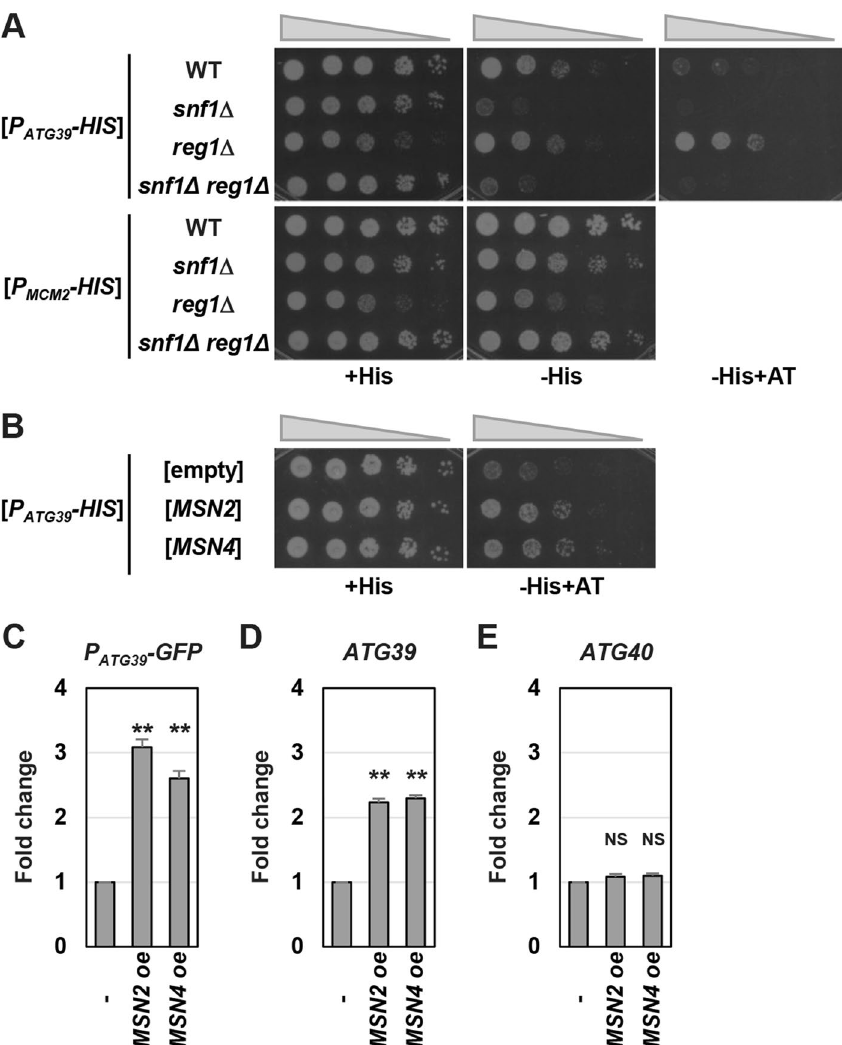
Figure 1. ATG39 expression is increased by Msn2/4 overexpression. ( A ) Effects of Snf1 activity on growth of cells harboring the P ATG39 -HIS3 reporter. Wild-type (WT) and indicated mutant strains harboring the P ATG39 - HIS3 or P MCM2 -HIS3 reporters were spotted onto synthetic defined media lacking or containing histidine (His) and 3-amino-1 H -1,2,4-triazole (AT), and incubated at 25 °C. ( B ) Effects of MSN2 / 4 overexpression on growth of cells harboring the P ATG39 -HIS3 reporter. Wild-type (WT) cells harboring the P ATG39 -HIS3 reporter and the plasmids with or without the MSN2 / 4 genes were spotted onto synthetic defined media lacking or containing histidine (H) and 3-amino-1H-1,2,4-triazole (AT), and incubated at 25 °C. ( C ) Effects of MSN2 / 4 overexpression on expression of the P ATG39 -GFP reporter. Wild-type strains harboring the P ATG39 -GFP reporter and the plasmids with or without the MSN2 / 4 genes were grown at 25 °C until exponential phase and then harvested. The GFP mRNA levels were quantified by qRT-PCR analysis, and relative mRNA levels were calculated using ACT1 mRNA. The values are plotted as the fold change from cells harboring the empty plasmids. The data show mean ± SEM (n = 3). ** P < 0.01 as determined by Student’s t -test. ( D , E ) Effects of MSN2 / 4 overexpression on the mRNA levels of ATG39 ( D ) and ATG40 ( E ). Wild-type strains harboring the plasmids with or without the MSN2 / 4 genes were grown at 25 °C until exponential phase and then harvested. The mRNA levels were quantified by qRT-PCR analysis, and relative mRNA levels were calculated using ACT1 mRNA. The values are plotted as the fold change from cells harboring the empty plasmids. The data show mean ± SEM (n = 3). ** P < 0.01 as determined by Student’s t -test. NS, not statistically significant ( P >